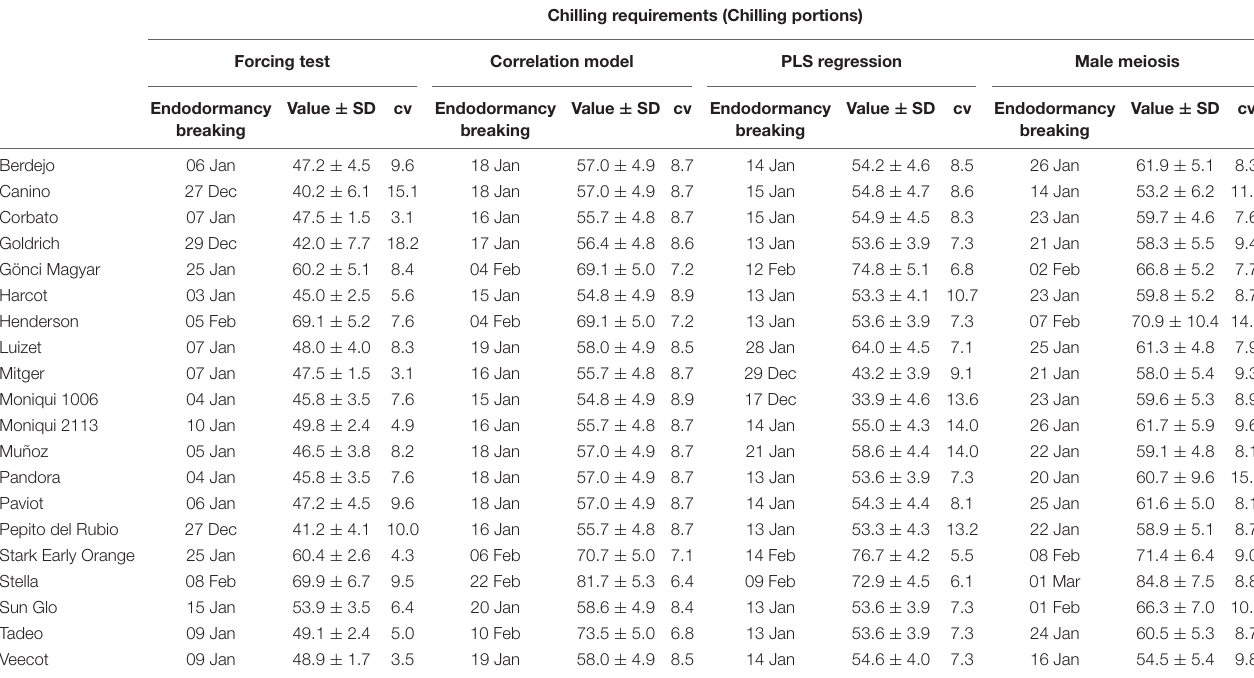
TABLE 1 | Dates of endodormancy and chilling requirements of 20 apricot cultivars determined according to four methods (forcing test, correlation, PLS, and male meiosis).